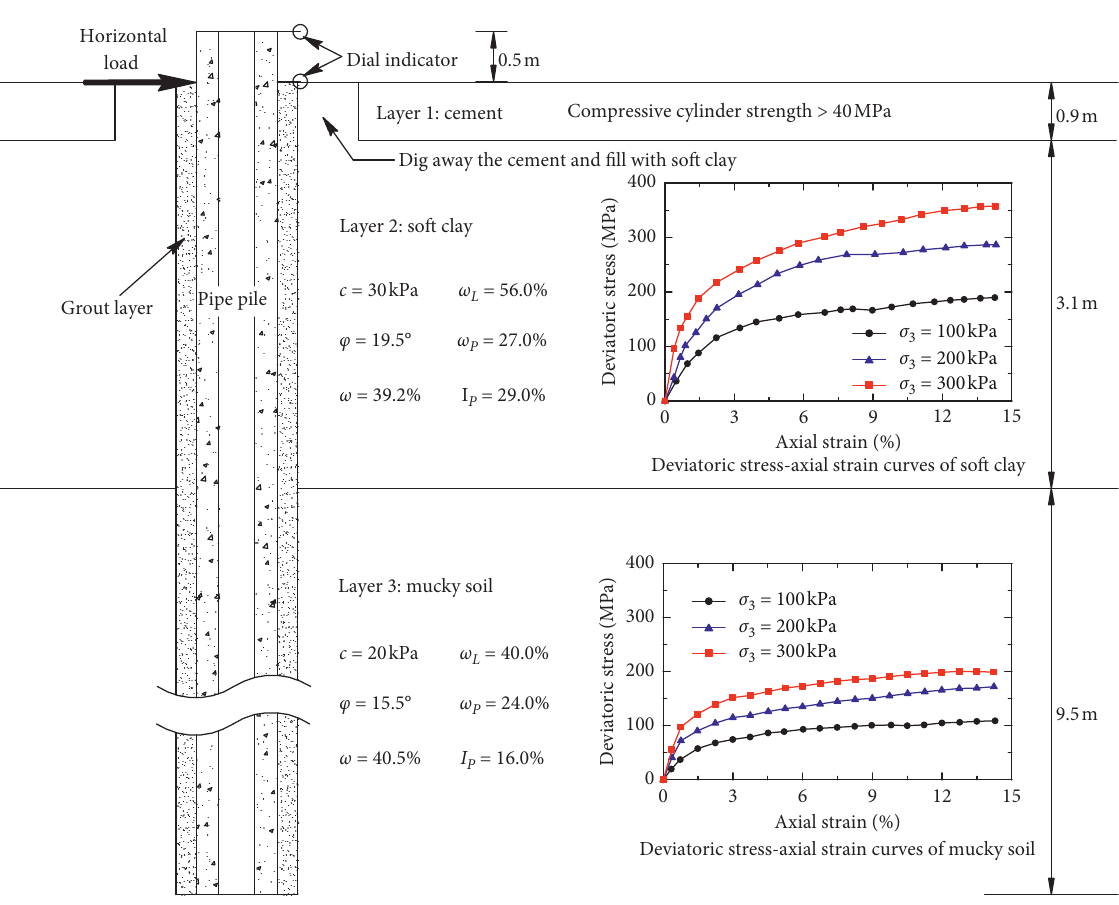
Figure 2: The outline situation of lateral static load test of the Drilled and Postgrouted Concrete Pipe